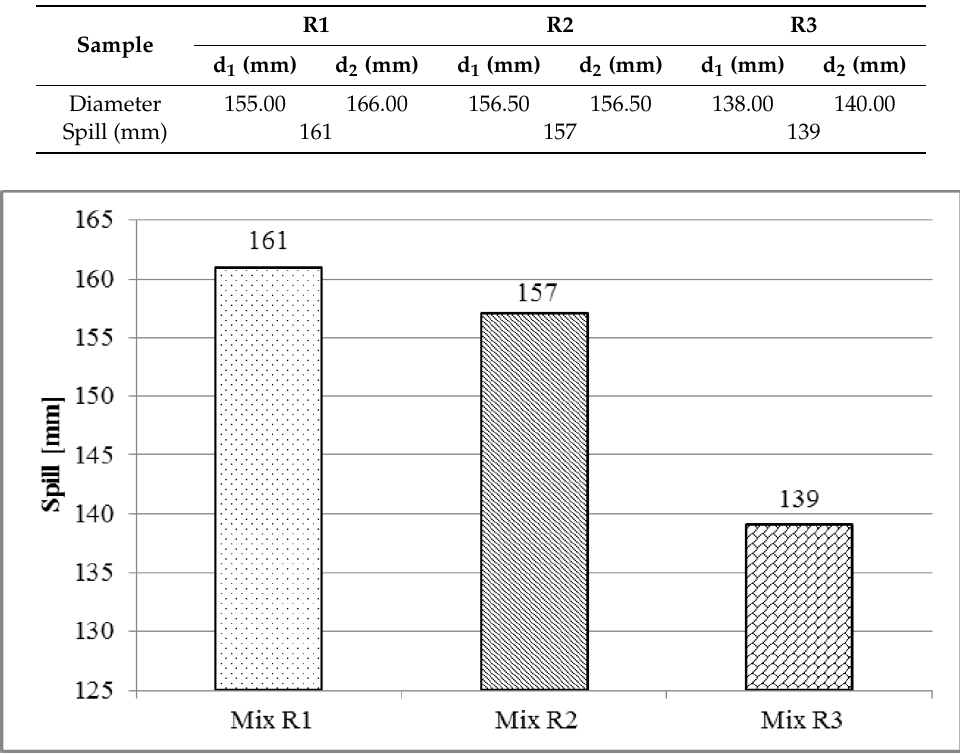
Figure 1. Chart showing the differences among the individual recipes.